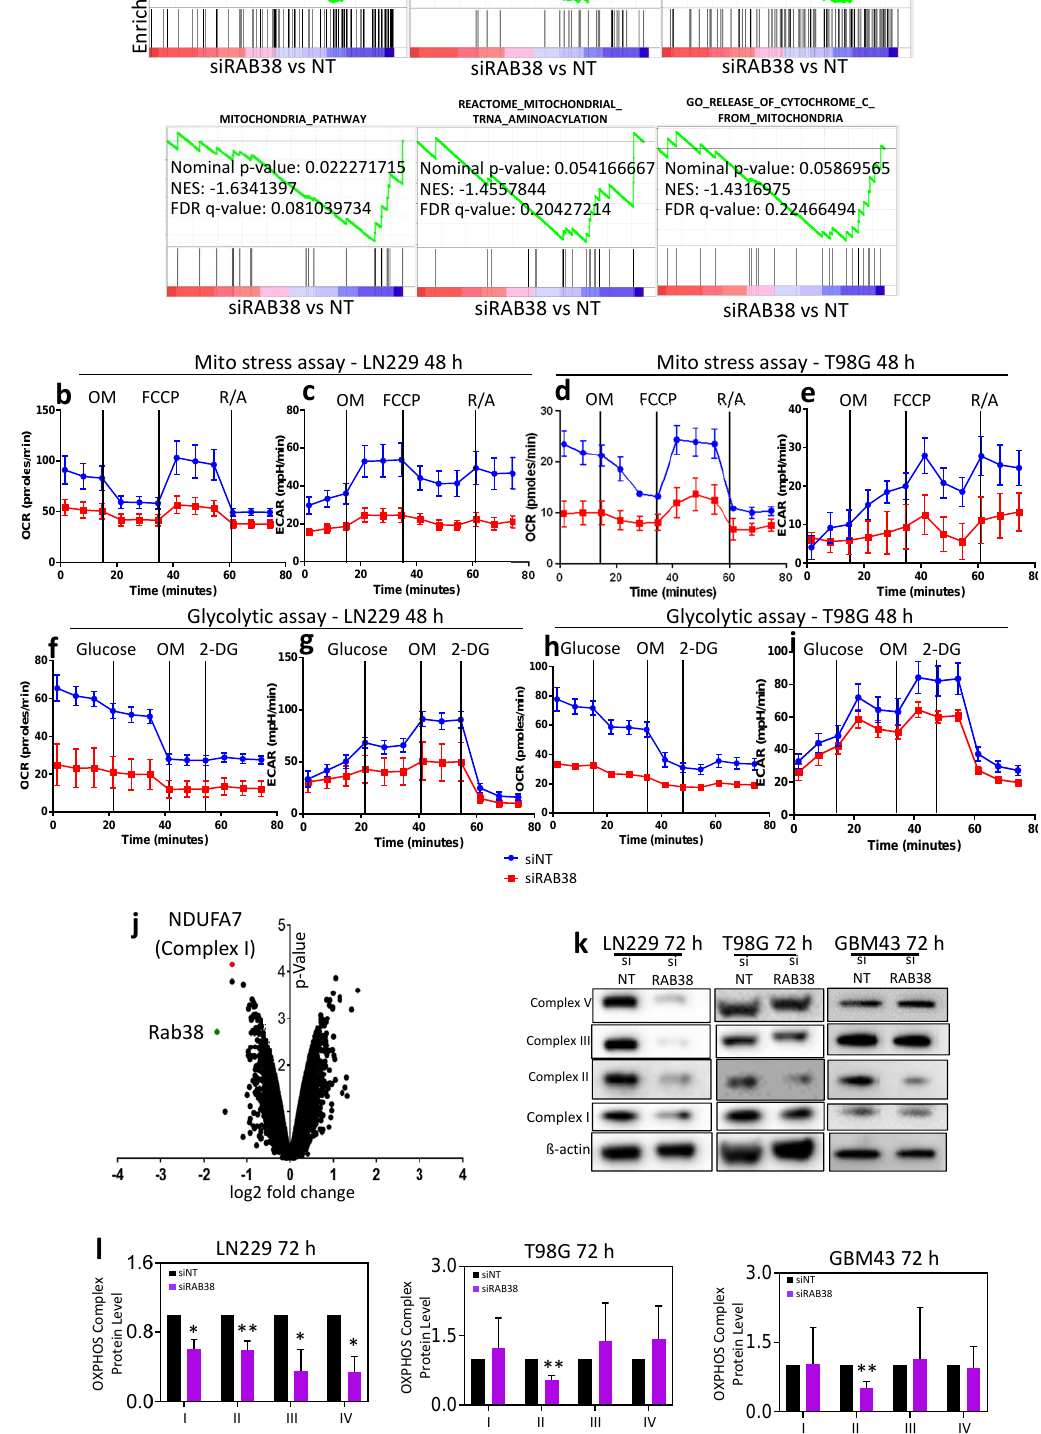
Figure 3. RAB38 silencing leads to inhibition of mitochondrial energy metabolism ( a ). LN229 cells were transfected